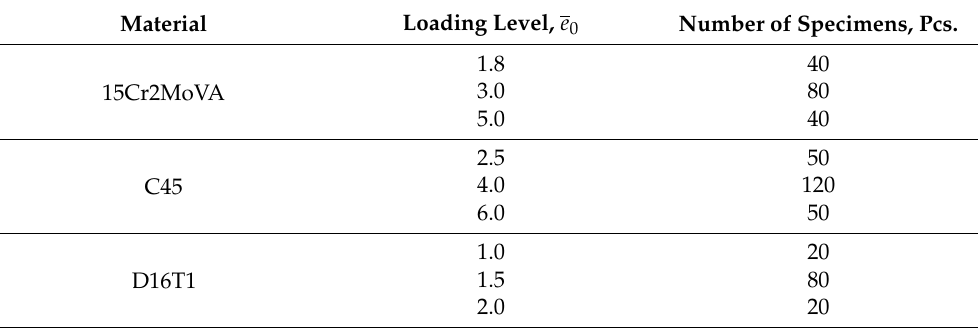
Table 3. Specification of low-cycle strain-controlled loading ( e 0 = constant )